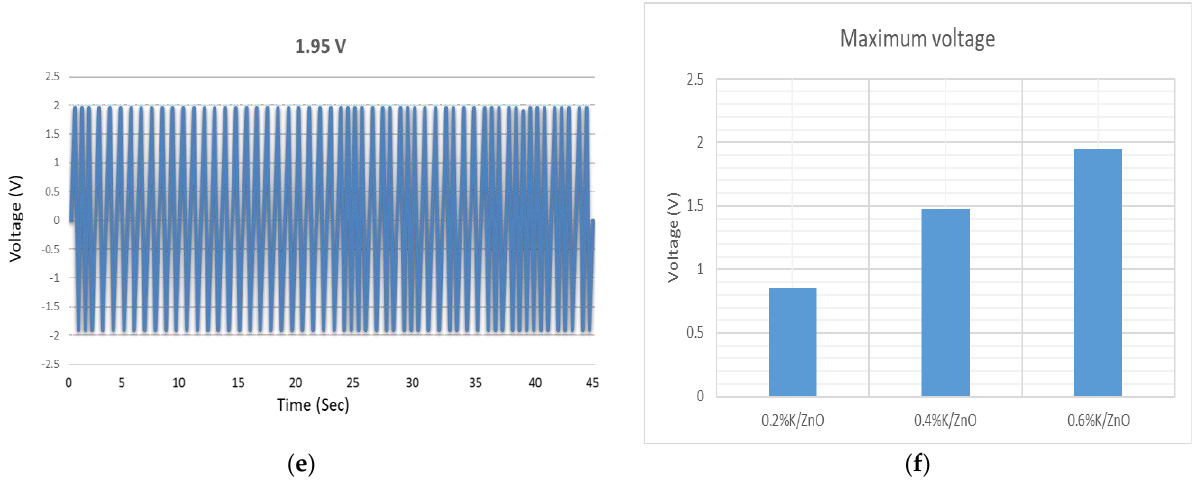
Figure 6. Output voltage values generated by ZnO nanowires based VING, ( a ) as-grown, ( c ) 2% K/ZnO ( d ) 4% K/ZnO ( e ) 6% K/ZnO ( b ) voltage histogram, ( f ) voltage bar graph for various K doping concentrations.